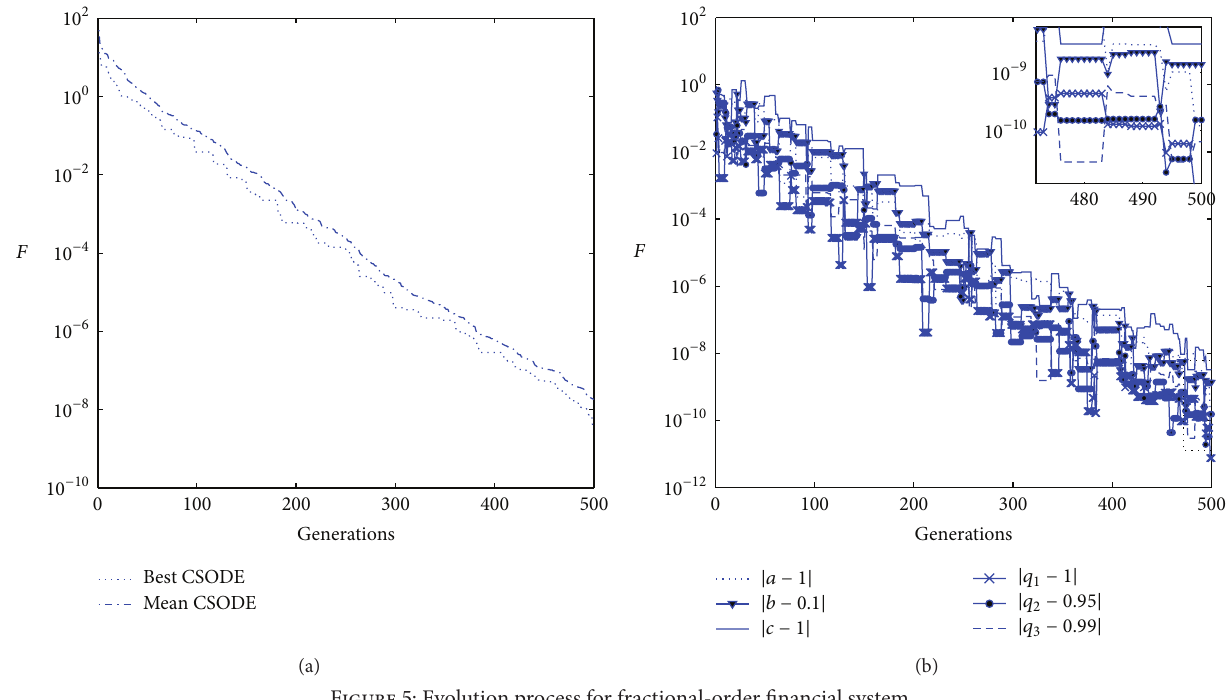
Figure 5: Evolution process for fractional-order financial